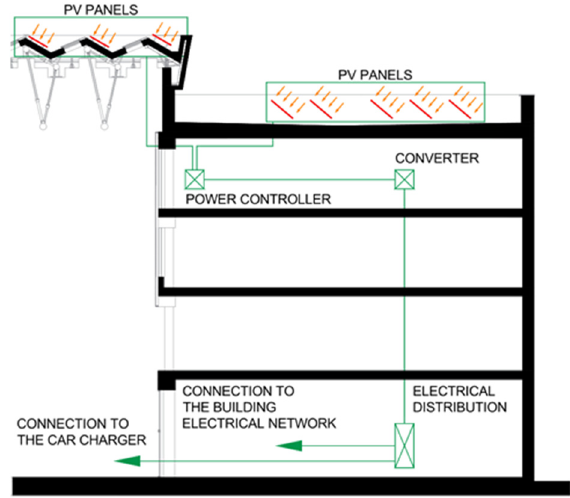
Figure 10. Photo of aluminum substructure on the